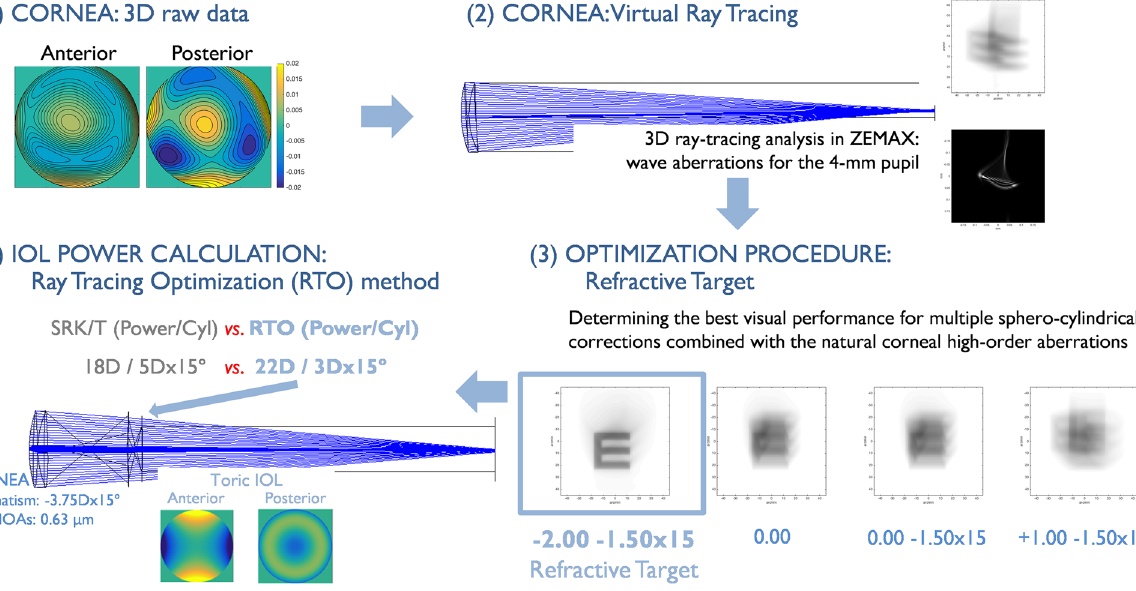
Figure 1. Illustration of the ray tracing optimization (RTO) method for IOL power calculation. (1) Corneal input data: anterior and posterior three-dimensional corneal elevation maps (SyntEye at 36 months; #145); (2) virtual ray tracing through the anterior and posterior corneal surfaces to determine the corneal wavefront aberrations at the pupil plane and the simulated visual performance (the point spread function, PSF, and the Snellen E-letter of 30 arc-min for 4-mm pupil diameter); (3) through-focus optimization process to calculate the sphero-cylindrical correction producing the highest VSOTF (representation of the Snellen E letter for different astigmatism and defocus magnitudes); and (4) pseudophakic virtual